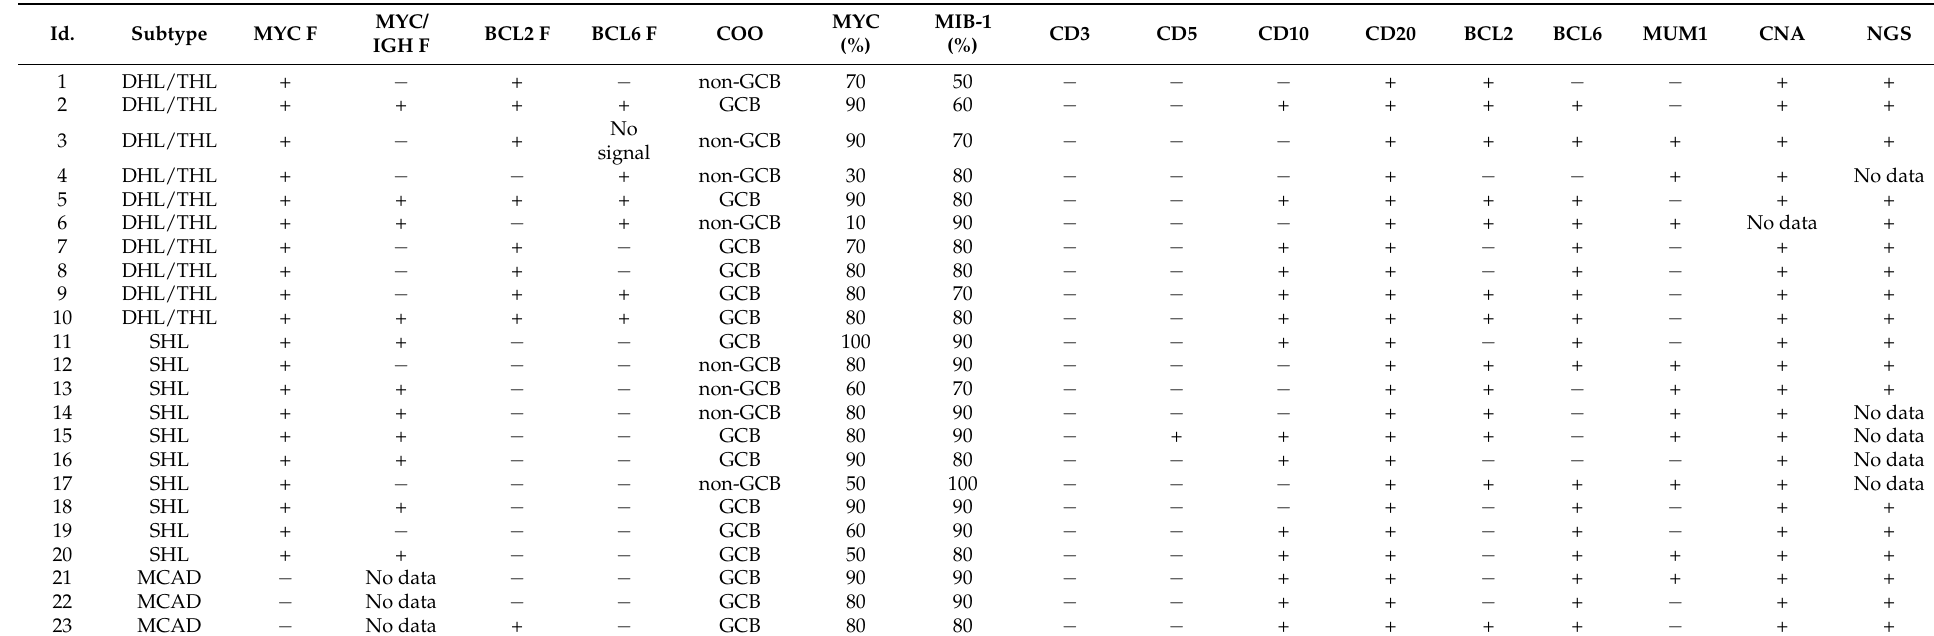
Table A2. Clinicopathological data of the 23 cases